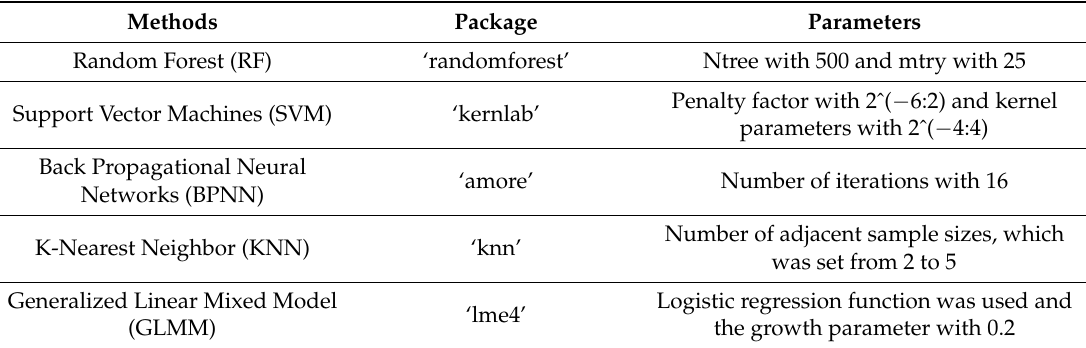
Table 3. The packages and parameters of five methods used in the